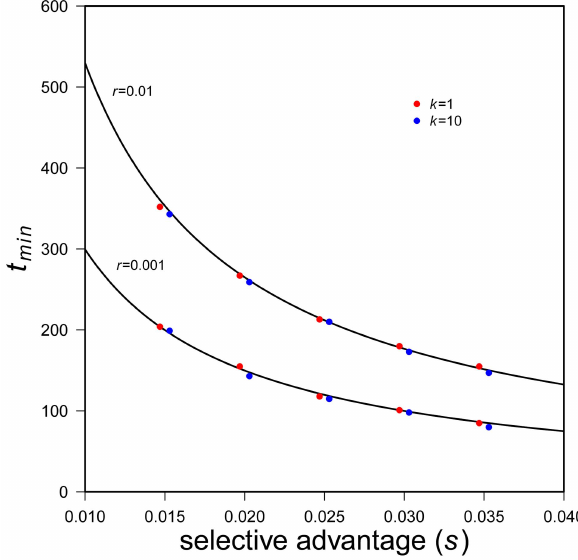
Figure 5. Time to minimum expected population size. Black lines are predicted t min (Eq. 13), simulation results with k =1 are red dots, simulation results with k =10 are blue dots. Two values of r are used (see plot), N 0 =10,000. 5000 successful realizations for each set of parameters.